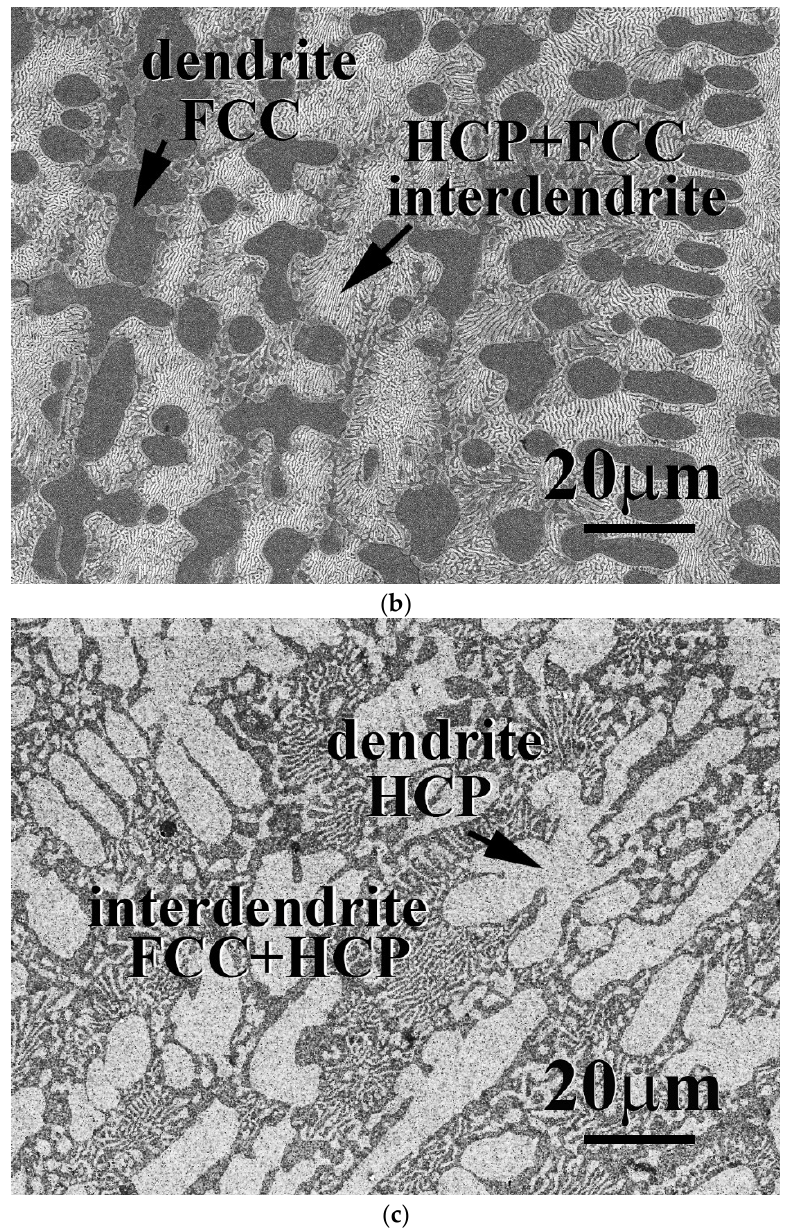
Figure 1. SEM micrographs of as-cast CrFeCoNiNb x Mo x alloys: ( a ) CrFeCoNiNb 0.15 Mo 0.15 alloy; ( b ) CrFeCoNiNb 0.3 Mo 0.3 alloy; ( c ) CrFeCoNiNb 0.5 Mo 0.5 alloy. Table 2. The chemical compositions of the as-cast CrFeCoNiNb x Mo x alloys and the phases in each alloy analyzed by SEM/EDS.